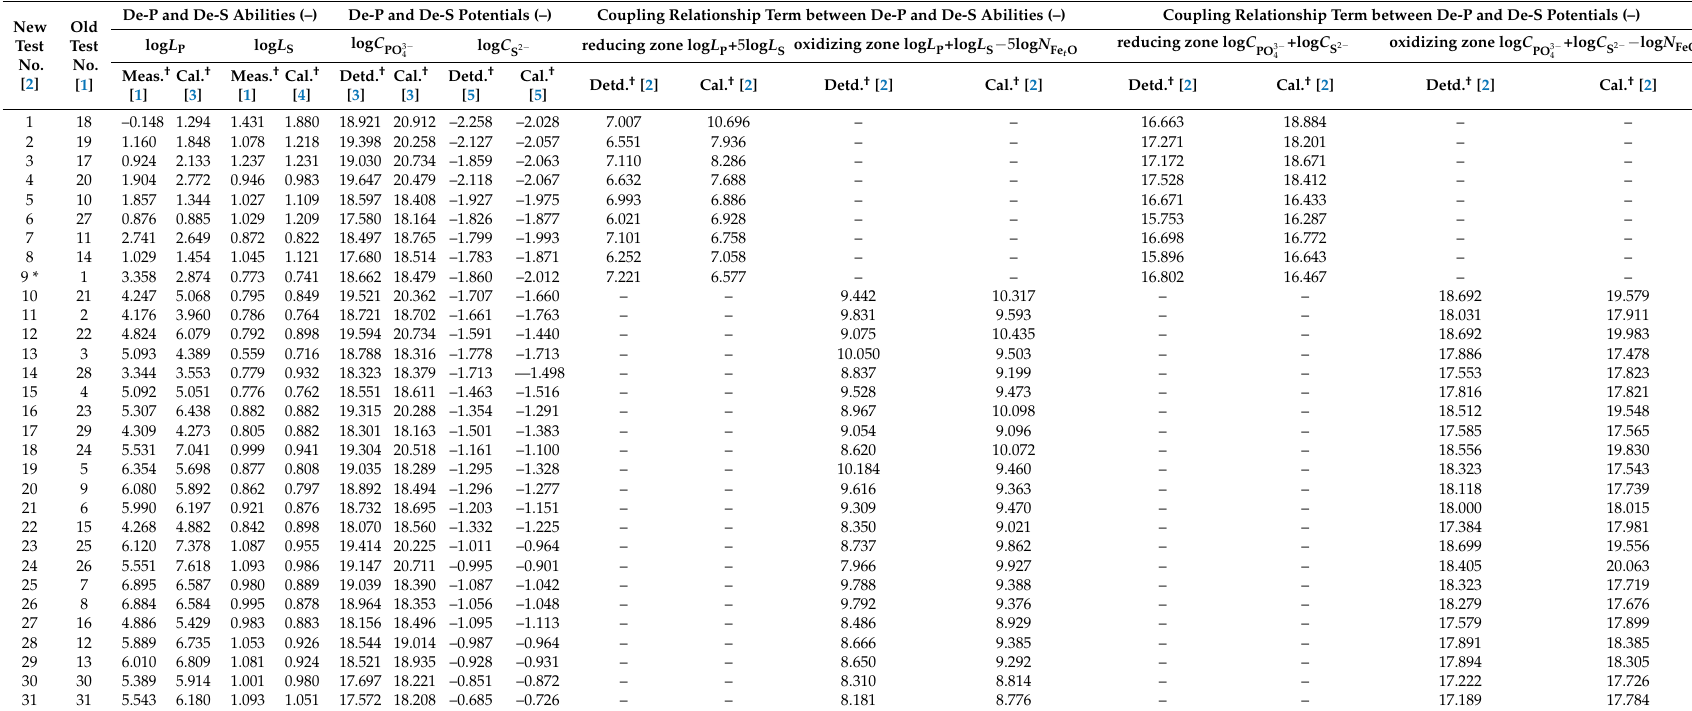
Table 2. Comparison between determined and calculated coupling relationship terms between dephosphorization and desulfurization abilities or potentials for CaO–FeO–Fe 2 O 3 –Al 2 O 3 –P 2 O 5 slags over a large range of slag oxidization ability equilibrated with liquid iron during the secondary refining process of molten steel based on measured log L P, measured or log L S, measured by Ban-ya et al. [1], predicted log L IMCT [3] or log L IMCT [4] by the IMCT models, determined P, calculated S, calculated log C [3] or determined log C [5] after Ban-ya et al. [1], and predicted log C IMCT [3] or log C IMCT [5] by the IMCT models S 2 − , determined PO 3 − 4 , determined PO 3 − 4 , calculated S 2 − , calculated over a temperature range from 1811 to 1927 K (1538 to 1654 ◦